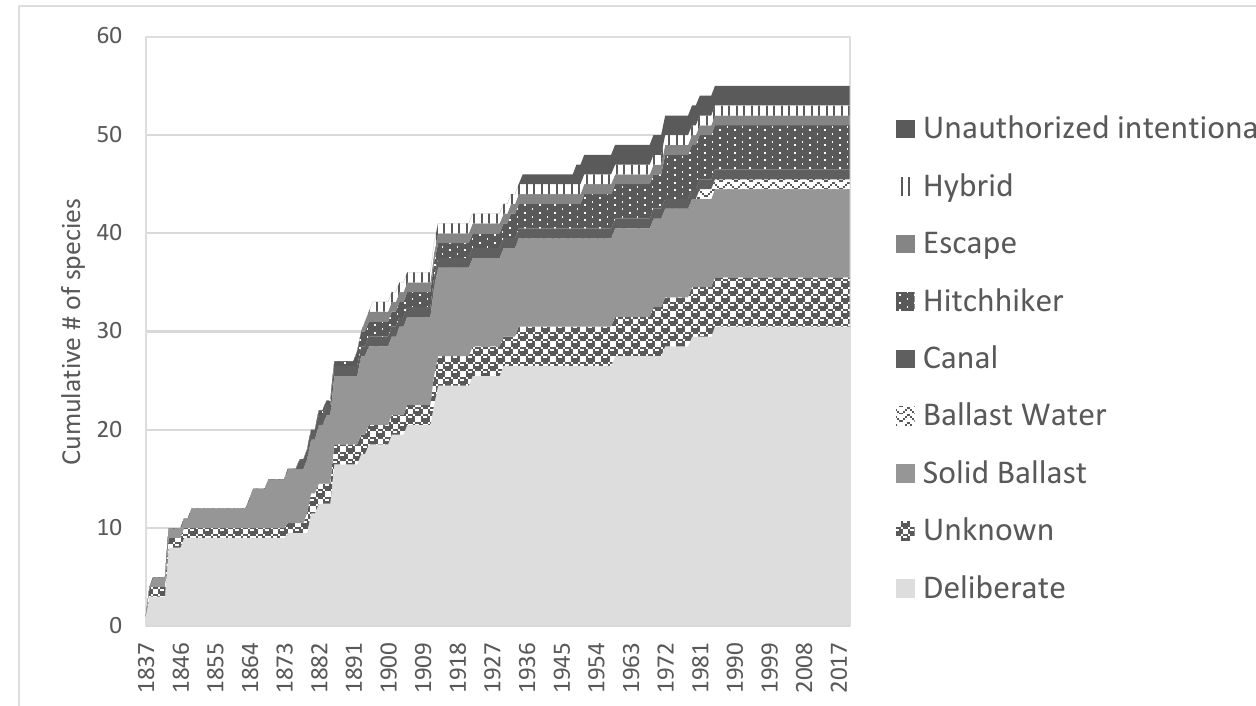
Figure 1. Cumulative introduction of nonindigenous plants to the Great Lakes basin by vector of introduction. Note the Hybrid vector represents recombination of a nonindigenous captive species introduced intentionally as a garden plant with a native plant, probably via